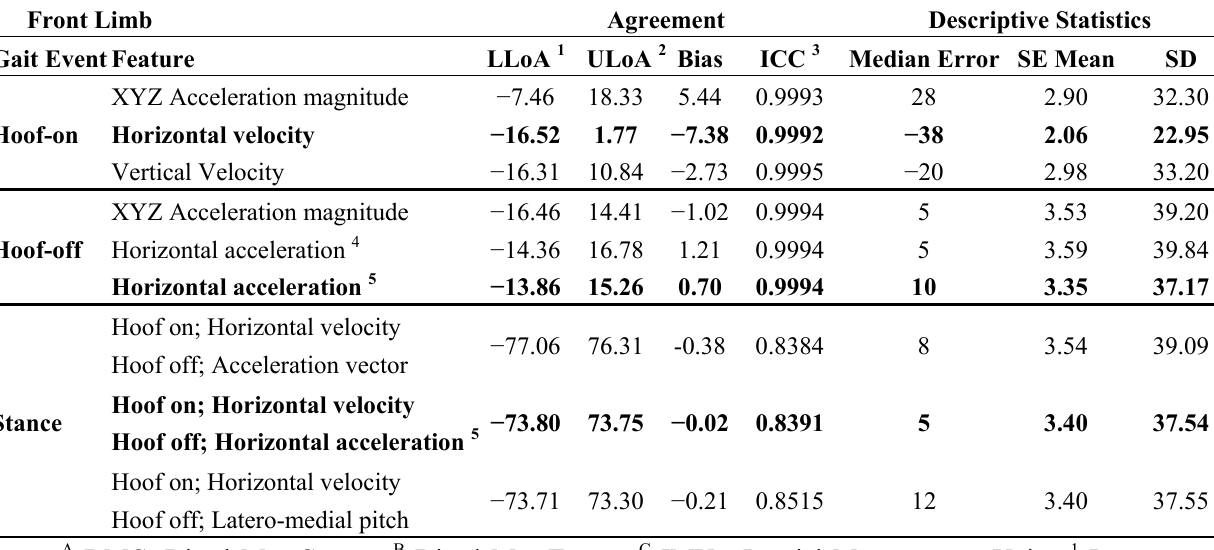
Table 1. Results from agreement analysis and descriptive statistics for front limb gait events. Displaying the three algorithms with the best (smallest) accuracy and precision, all based on features from DMC A /DMT B mounted IMUs C . All values are in ms. Values in bold have the best (smallest) accuracy and precision. The full table can be accessed online as supplementary